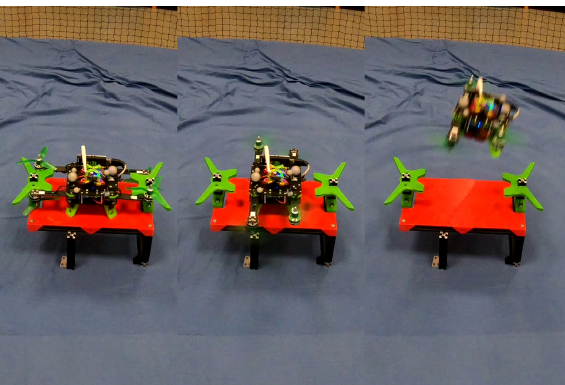
Figure 12. The landing platform for the reconfigurable drone, where the R-Shafter is locked on the platform ( left ). The drone is unlocked and ready to take off ( middle ). Drone take off ( right